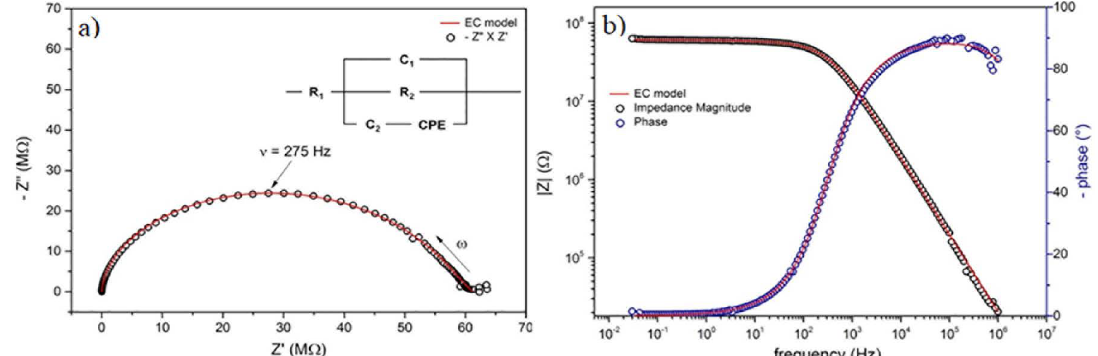
Figure 6. The semicircle represents the experimental data, and the red solid line comes from the fitting of the EC (a). The black and blue semicircles are experimental data for the impedance magnitude and phase, and the red solid line shows the EC fitting